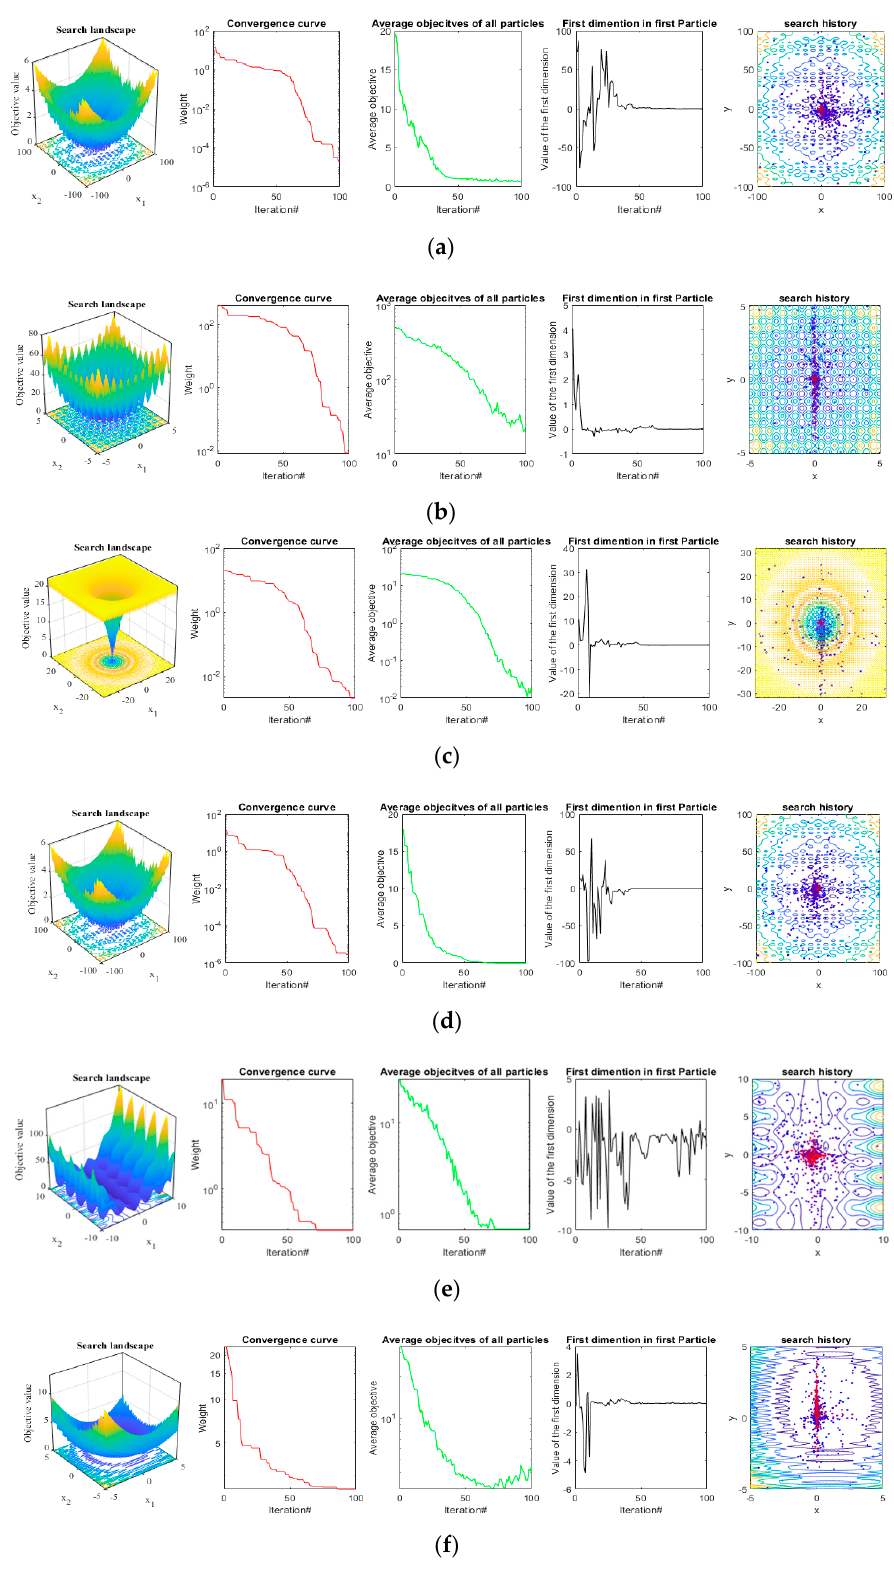
Figure 6. Landscape, Convergence curve, average Convergence curve, first dimension in first particle and search history for and NCSA for Multimodal Benchmark function f 8 – f 13 ( a – f ), ( a ) f 8 benchmark function, ( b ) f 9 benchmark function, ( c ) f 10 benchmark function, ( d ) f 11 benchmark function, ( e ) f 12 benchmark function and ( f ) f 13 benchmark function.